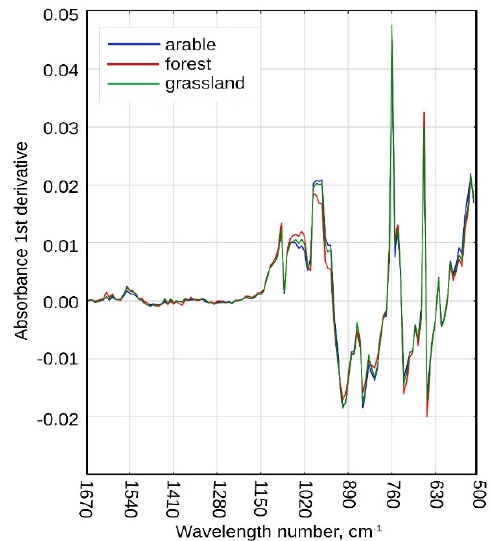
Figure 4. MIR spectra (in a range 500–1700 cm − 1 ) averaged for land use classes.